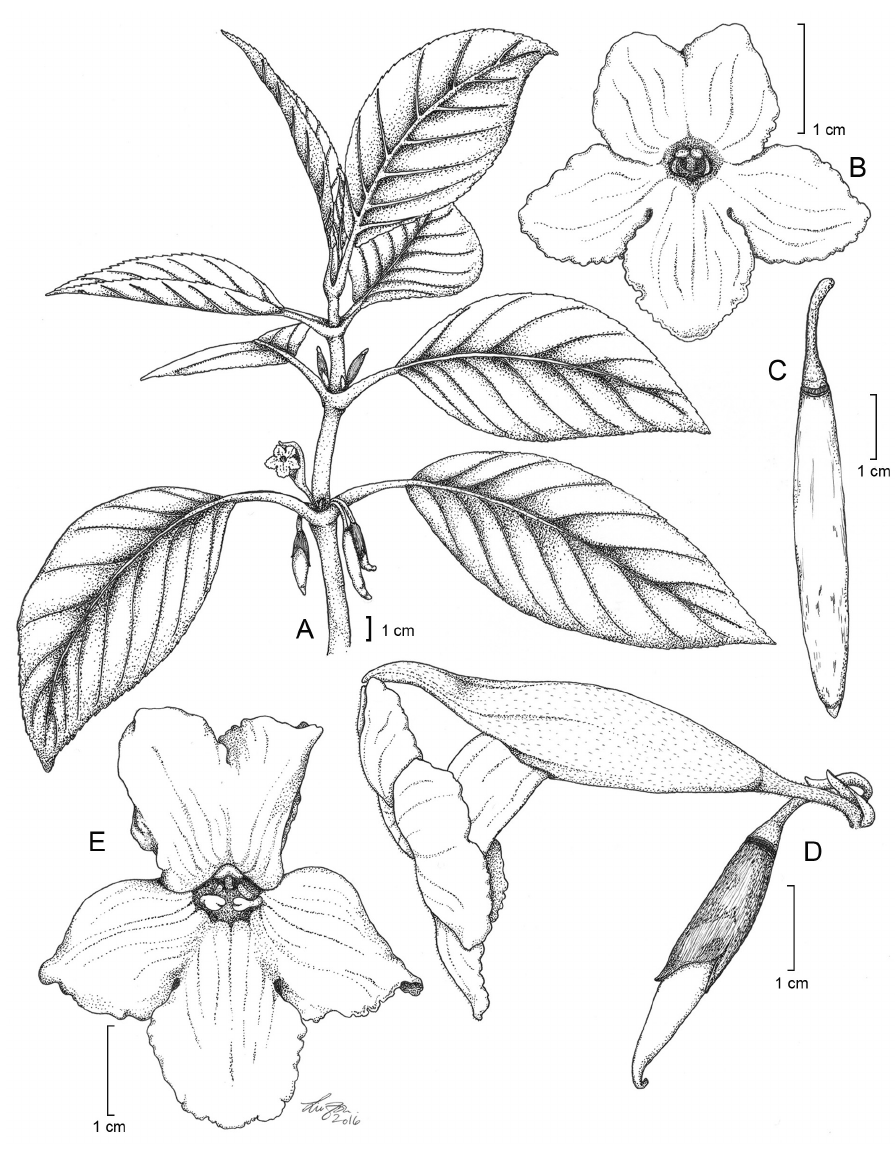
Figure 7. Cyrtandra longifructosa M.A.Johnson. A Habit B Corolla, staminate phase, anterior view C Mature elongate cylindrical fruit D Inflorescence and young fruit E Corolla, ovulate phase, anterior view. Drawn from Johnson 65 (SUVA, RSA), Johnson 59 (RSA), and field images. lanceolate, deciduous after anthesis, pedicels 11–18 mm long; calyx pale green, outer and inner surfaces pubescent with appressed uniseriate trichomes, narrowly fusiform in bud, 28–32 mm long, beaked, the 5 lobes often remaining connivent, splitting along one suture 14–19 mm long, deciduous; corolla white, becoming strongly bilabiate in